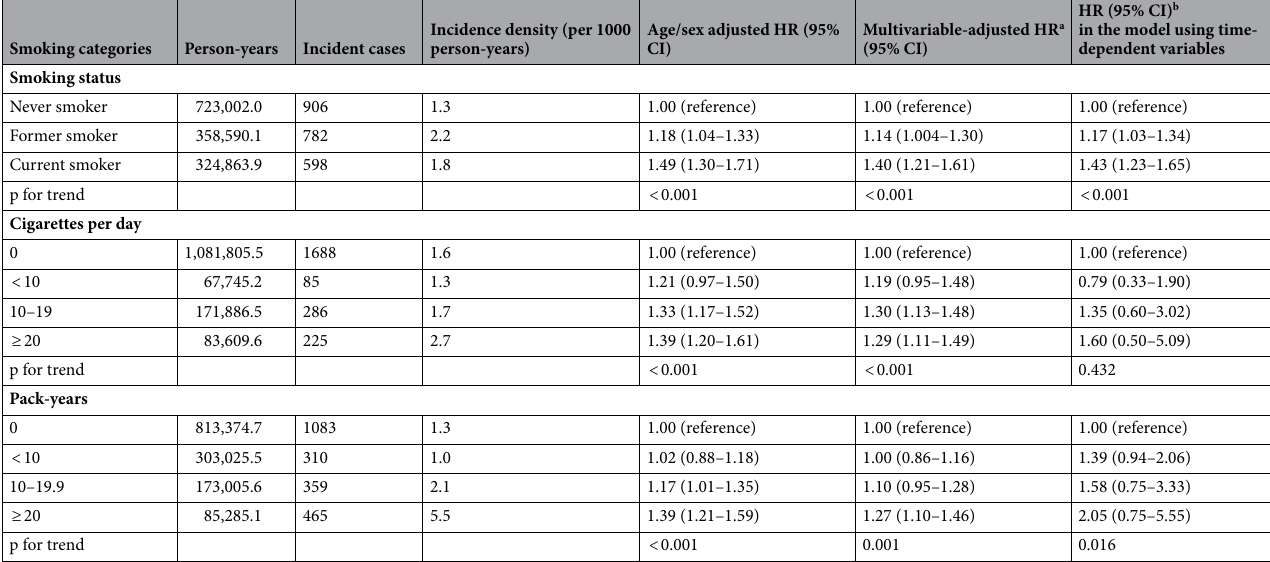
Table 2. Development of bilateral hearing loss by subjective measures of smoking status. BMI body mass index, CI confidence interval, CVD cardiovascular disease, HR hazard ratio. a Estimated from parametric proportional hazards models. Multivariable model was adjusted for age, sex, center, year of screening exam, BMI, physical activity, alcohol intake, total energy intake, educational level, medication for dyslipidemia, history of CVD, history of diabetes, history of hypertension, and occupational noise exposure. b Estimated from Cox proportional hazards models with smoking category, physical activity, alcohol intake, total energy intake, BMI, medication for dyslipidemia, history of diabetes, history of hypertension, history of cancer, history of CVD, and occupational noise exposure as time-dependent categorical variables and baseline age, sex, center, year of screening exam, and education level as time-fixed variables.